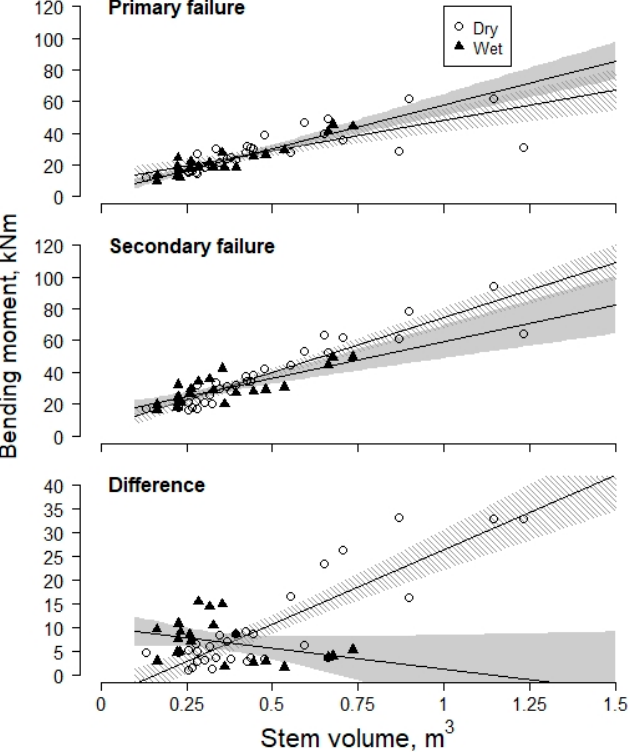
Figure 1. Basal bending moment of birch stems at the primary failure (BBM PF ) and the secondary failure (BBM SF ) as well as the difference (BBM dif ) between both BBM PF and BBM SF on well-drained mesotrophic (dry; stripped) and periodically waterlogged (wet; grey) mesotrophic mineral soils. The shaded area denotes 95% confidence interval. Table 3. Statistics of the refined mixed models relating basal bending moment at the primary (BBM PF ) and secondary (BBM SF ) failures of birch stem under destructive static loading as well as the difference (BBM dif ) between both BBM PF and BBM SF and root depth. Variances of the random effects of site and strength ( χ 2 -value) and significance ( p -values) of the fixed effects (significant effects are highlighted in bold) are shown. V stem– stem volume; SD–Standard deviation.